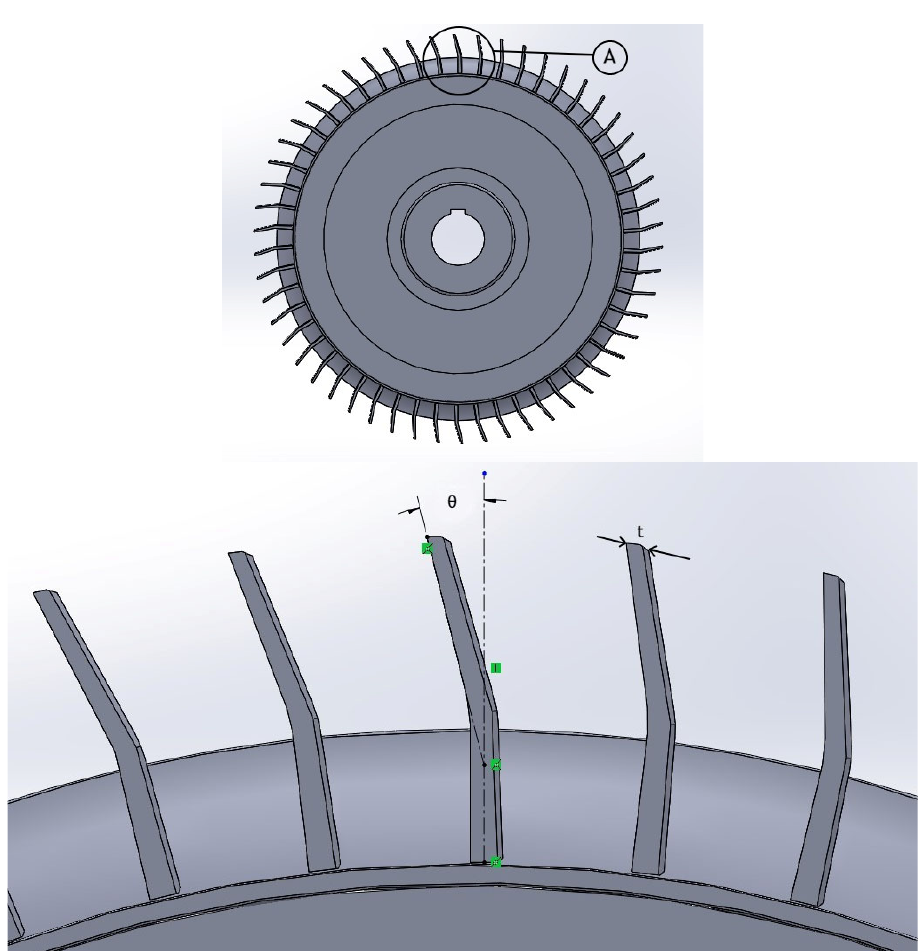
Figure 9. Schematic diagram of a peripheral vane impeller showing exit vane angle and vane thick ‐ ness at exit. Portion A is magnified for